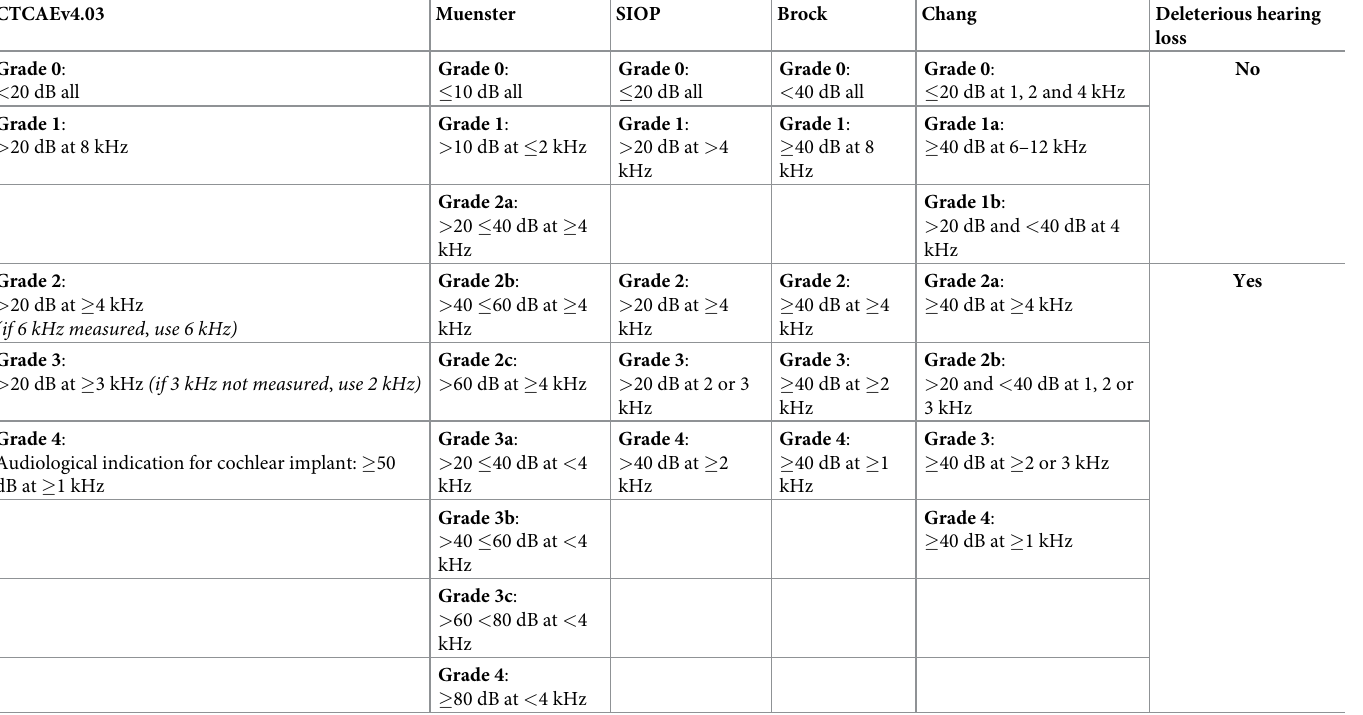
Table 1. Ototoxicity classification systems.